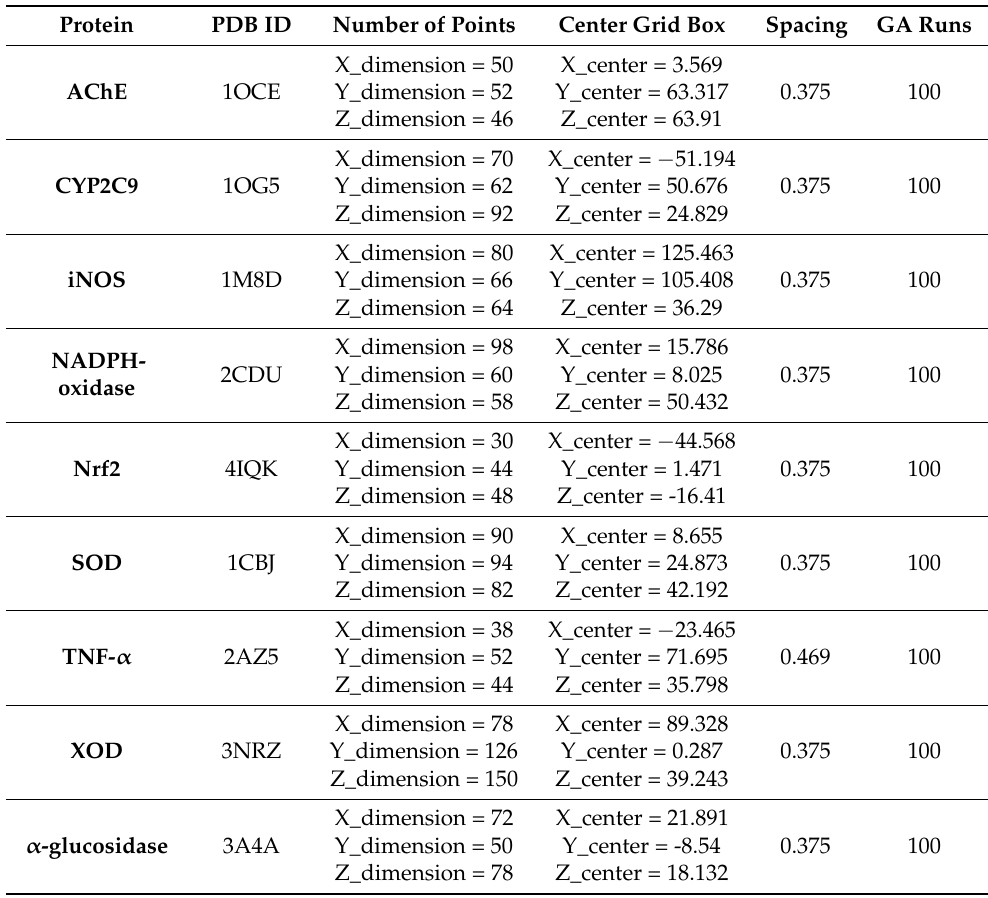
Table 1. Molecular docking parameters and protein